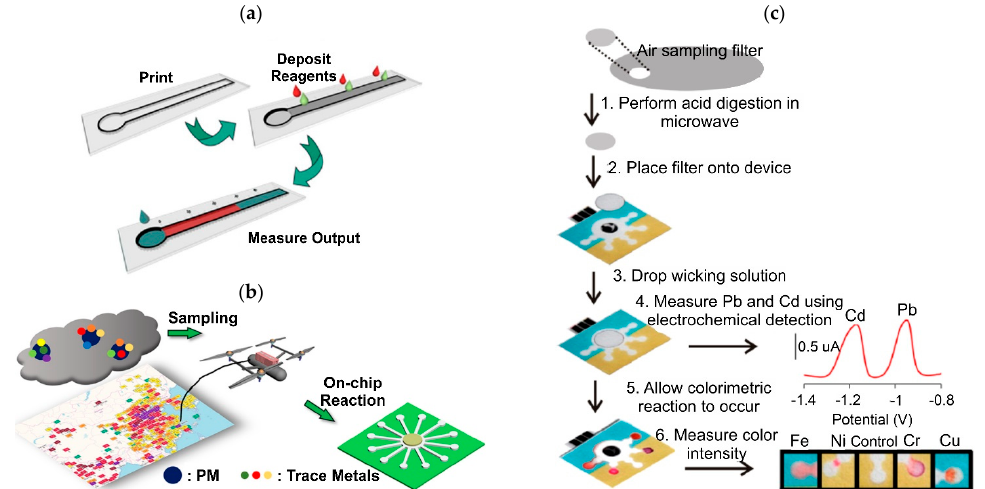
Figure 10. Paper-based microfluidic techniques for airborne PM detection. ( a ) Schematic diagram of a distance-based µPAD. Reprinted with permission from Reference [211]. Copyright (2015) American chemical Society. ( b ) Schematic diagram of a UAV-based approach for airborne particle sampling. Reprinted with permission from Reference [175]. Copyright (2019) American chemical Society. ( c ) Principle of operation of a mPAD. Reprinted from Reference [183] with permission from AIP Publishing.